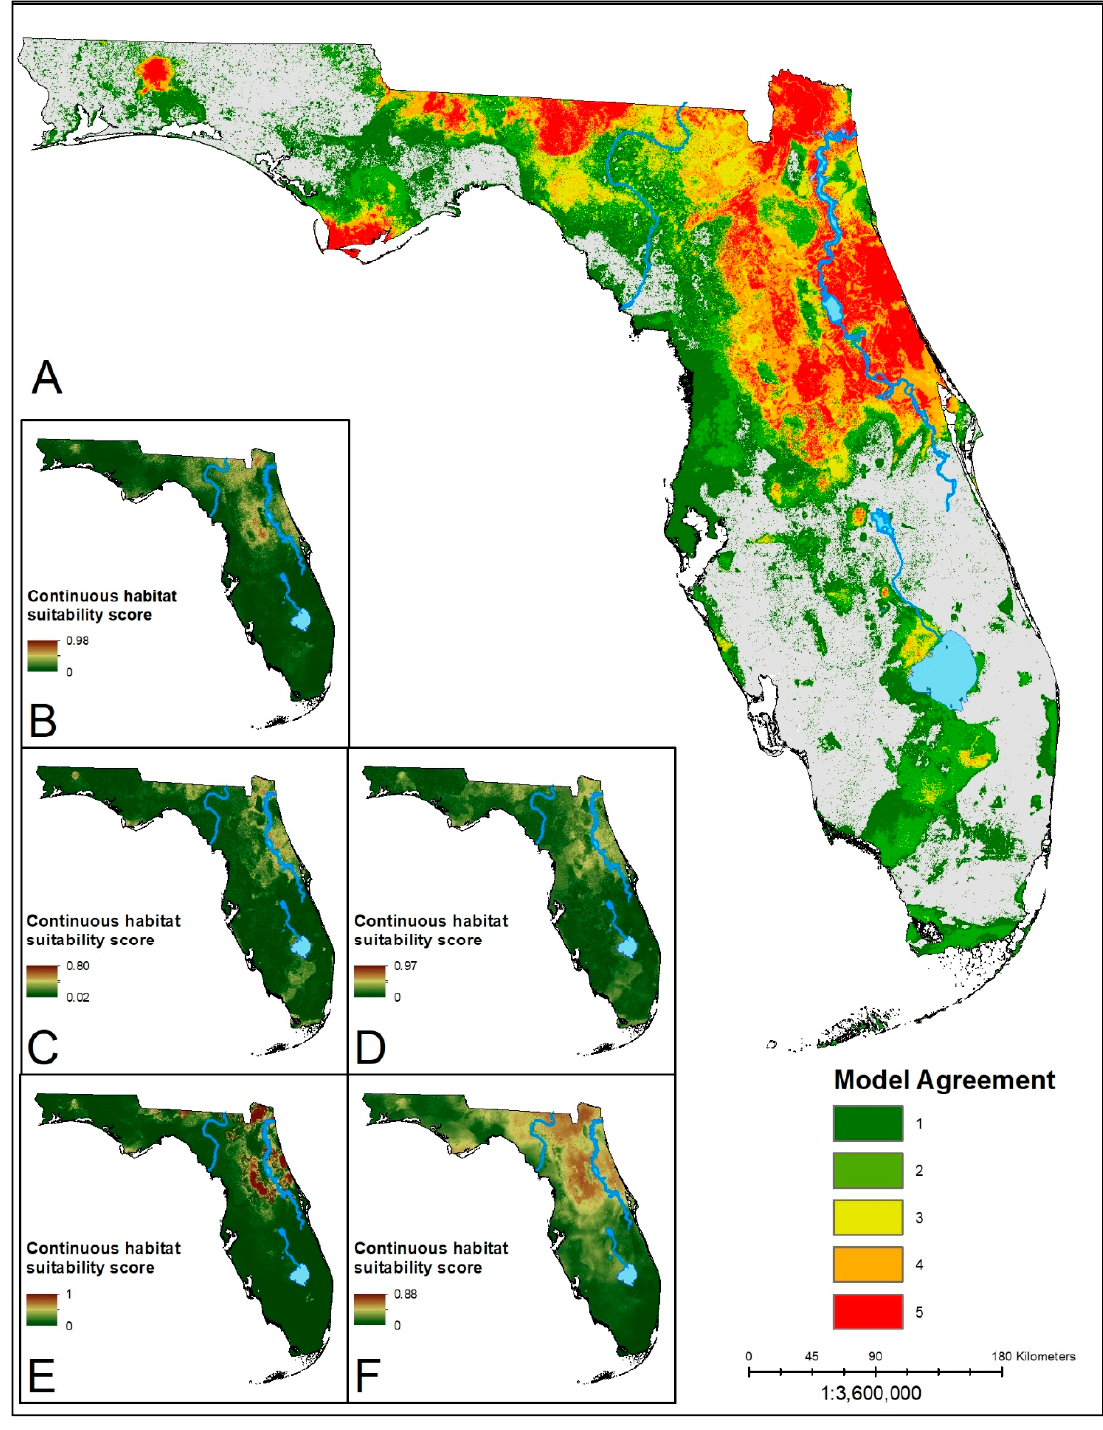
Figure 2. ( A ) Ensemble prediction of suitable habitat for I. scapularis . Hotter colors indicate higher agreement on habitat suitability across models for a given area. ( B – F ) Continuous suitability scores for the five modeling algorithms: LR, BRT, RF, MARS, MaxEnt, respectively. Much of the northeastern part of the state is deemed suitable by the majority of the models. Southern areas of predicted suitability show lower consensus.